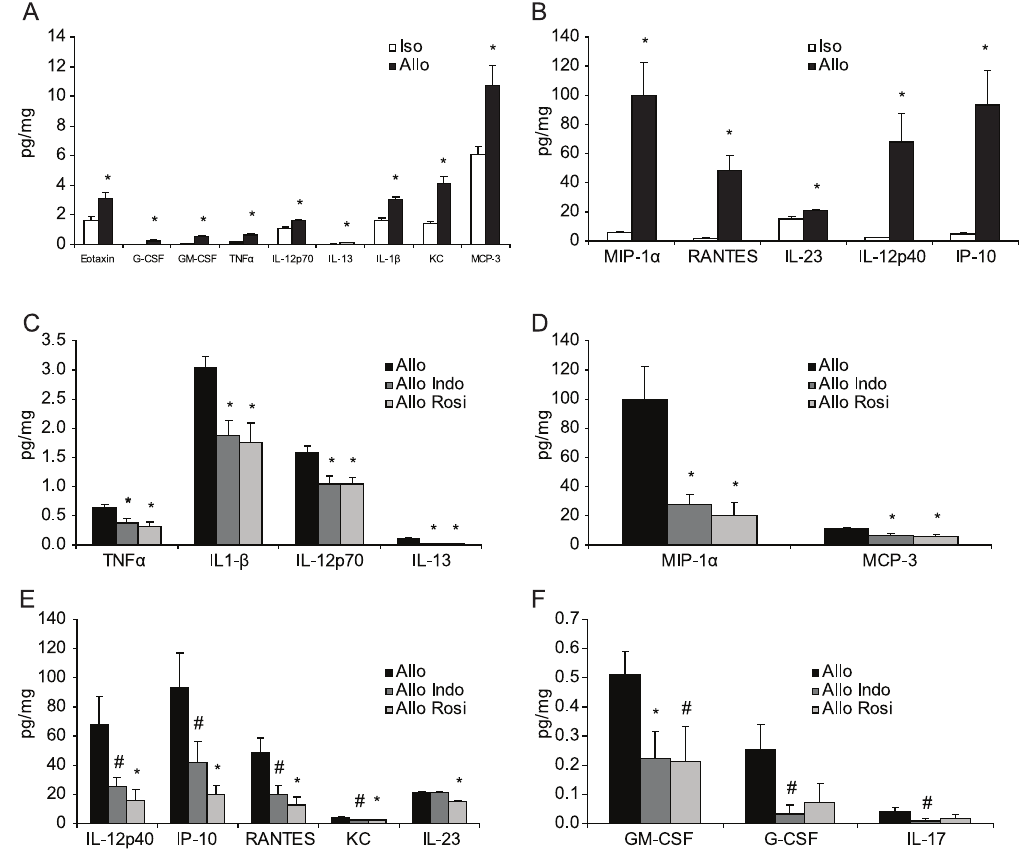
Figure 5. Treatment with NSAIDs Attenuates Cytokine Production in the Hippocampus. The hippocampi of isografted and allografted mice treated with or without NSAIDs were dissected 48 hrs after transplantation and protein extracts evaluated by Luminex 25-plex cytokine assay. ( A,B ) 14 of the 25 tested cytokines showed significant upregulation, including eotaxin, G-CSF, GM-CSF, TNF a , IL-12p70, IL-13, IL-1 b , KC, MCP-3, MIP- 1 a , RANTES, IL-23, IL-12p40 and IP-10. ( C,D ) Treatment with indomethacin or rosiglitazone significantly reduced the cytokine production in the allograft group, including TNF a , IL-1 b , IL-12p70, IL-13, MIP-1 a and MCP-3. ( E,F ) After indomethacin treatment, GM-CSF was also significantly decreased and the expression of IL-12p40, IP-10, RANTES, KC, G-CSF and IL-17 showed a trend towards down regulation. Rosiglitazone treatment also significantly reduced the production of IL-12p40, IP-10, RANTES, KC and IL-23. * p , 0.05, # p , 0.1, n=5–6.